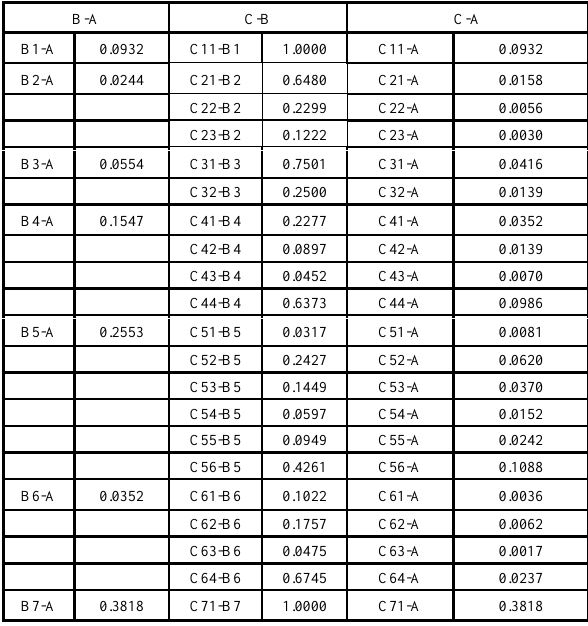
Table 4. Weight calculation results